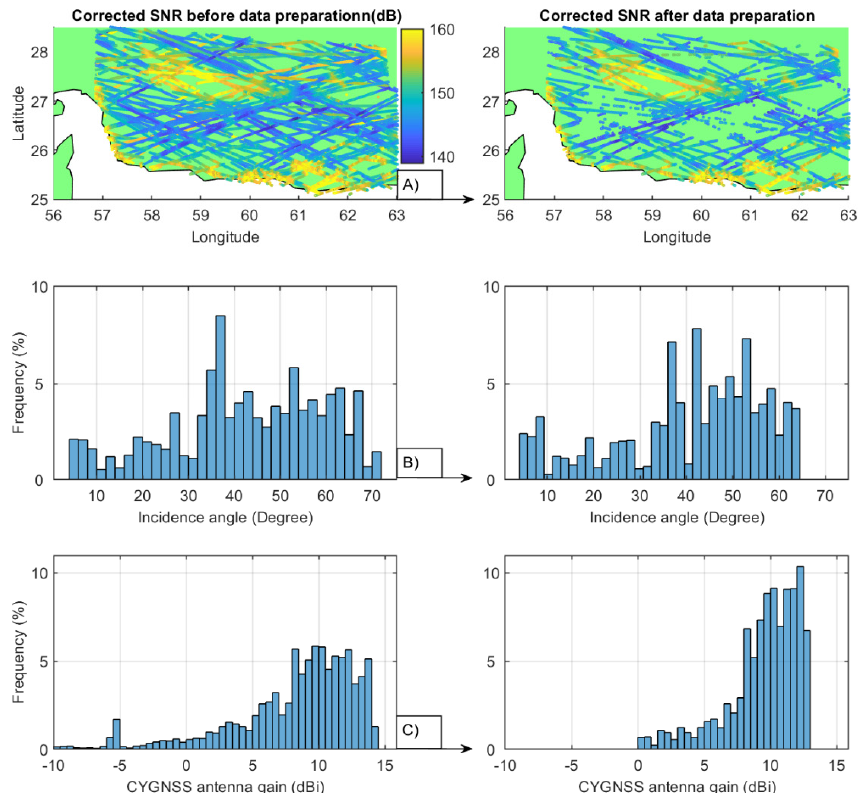
Figure 7. Statistical information of the data preparation step for the CYGNSS observations over a period of three days (13 January to 15 January 2020). ( A ) Corrected signal-to-noise ratio (SNR) before and after the preprocessing step. ( B , C ) The distribution of data according to incidence angle and antenna gain before and after data preparation.